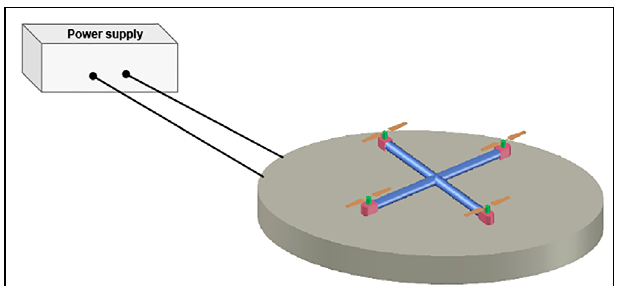
FIGURE 7 | Charging stations for UAVs (Choi et al. (2016); Galimov et al. (2020)).